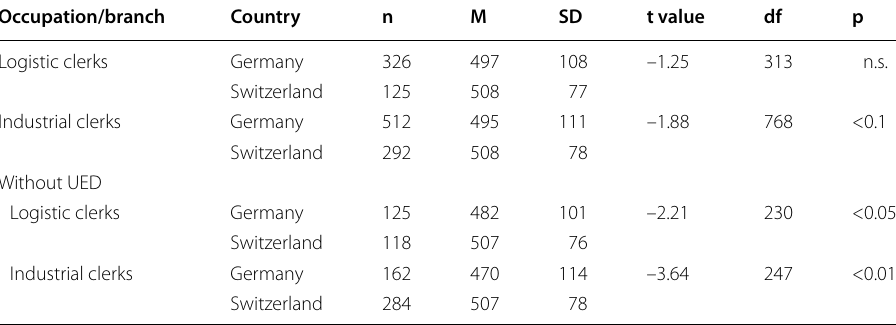
UED University entrance degree